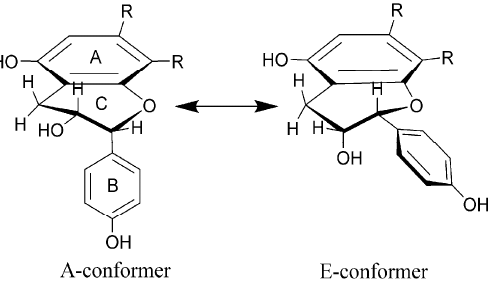
Figure 4. Structures of A and E conformers. Ring B is in a pseudo-axial position in the A-conformer and in a pseudo-equatorial position in the E-conformer.